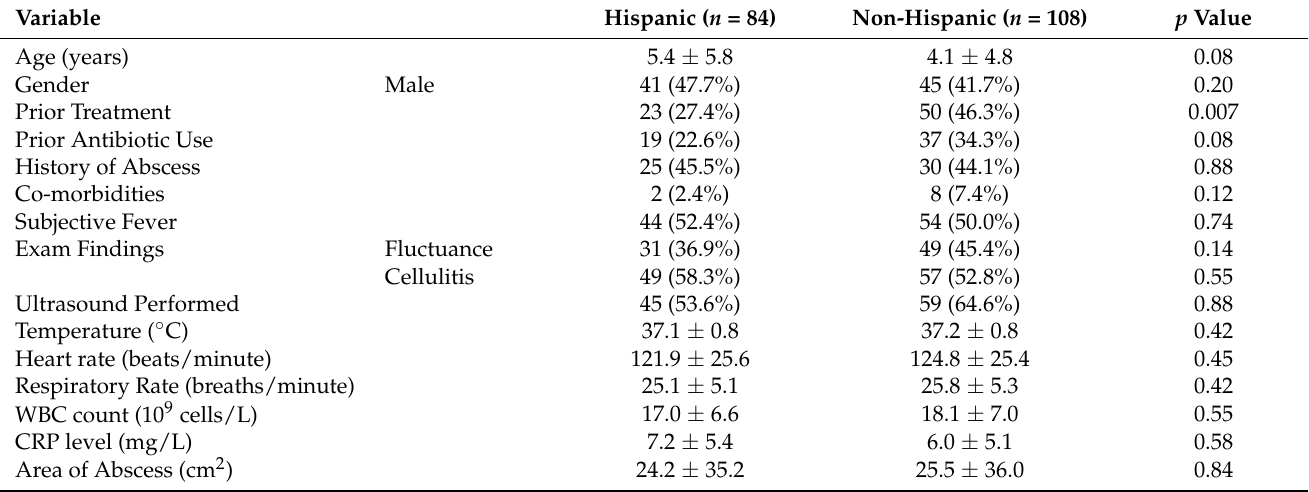
Table 2. Hispanic vs.